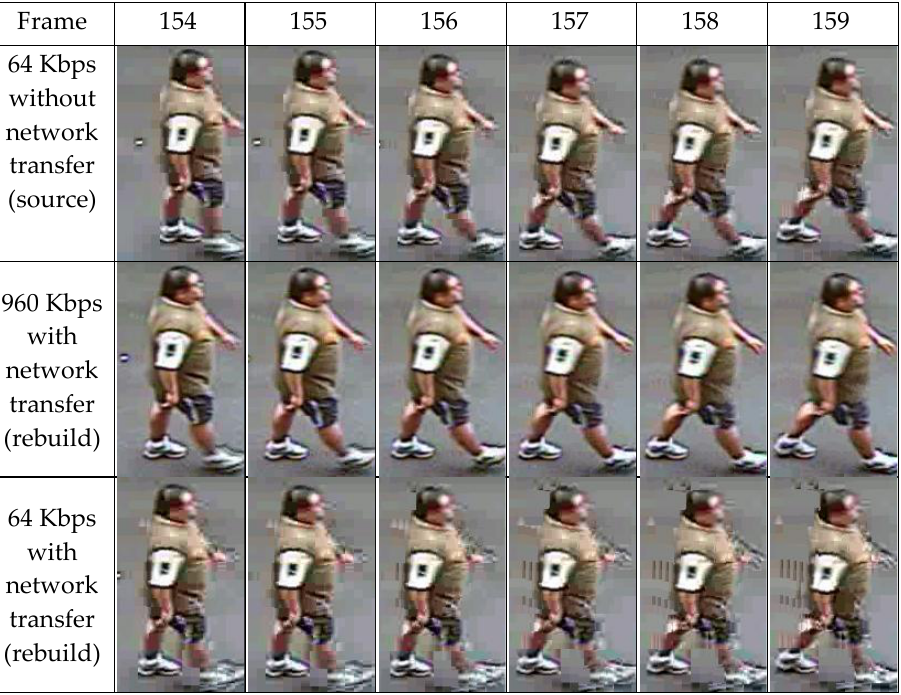
Figure 10. Successive frames in scenario 56 (frames 154 – 159).